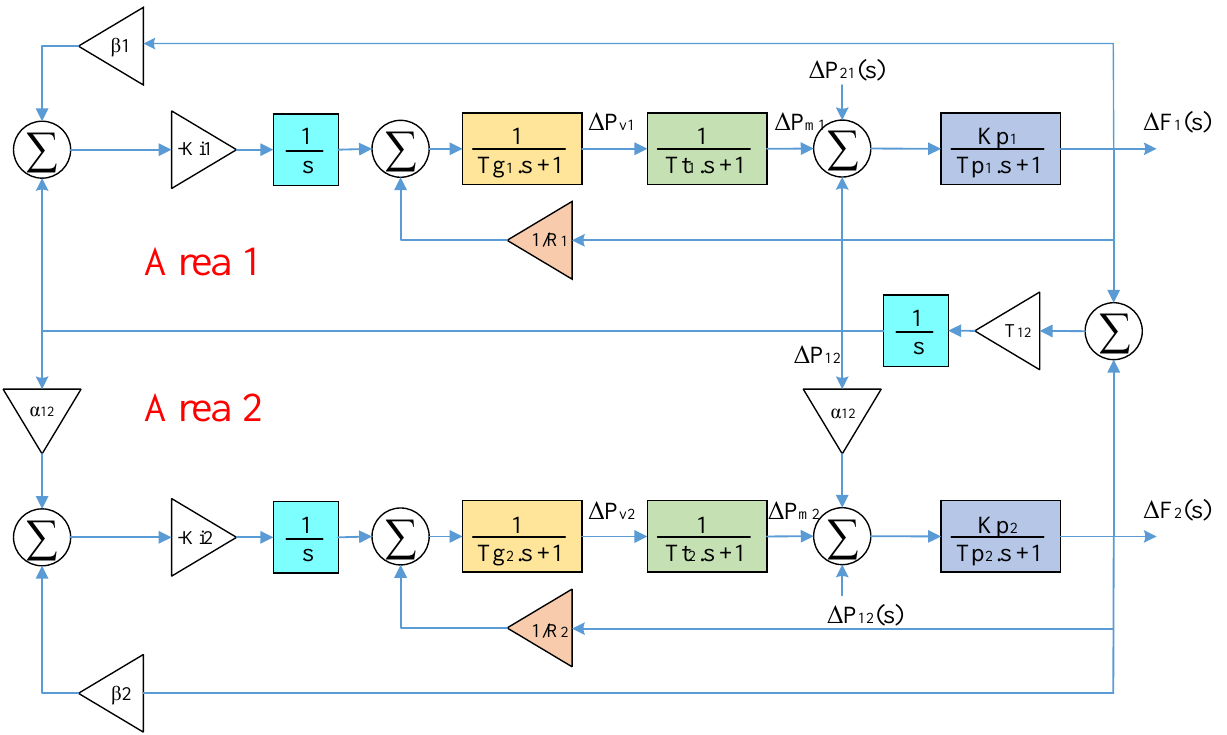
Figure 4. LFC block diagram of a dual-area power system.